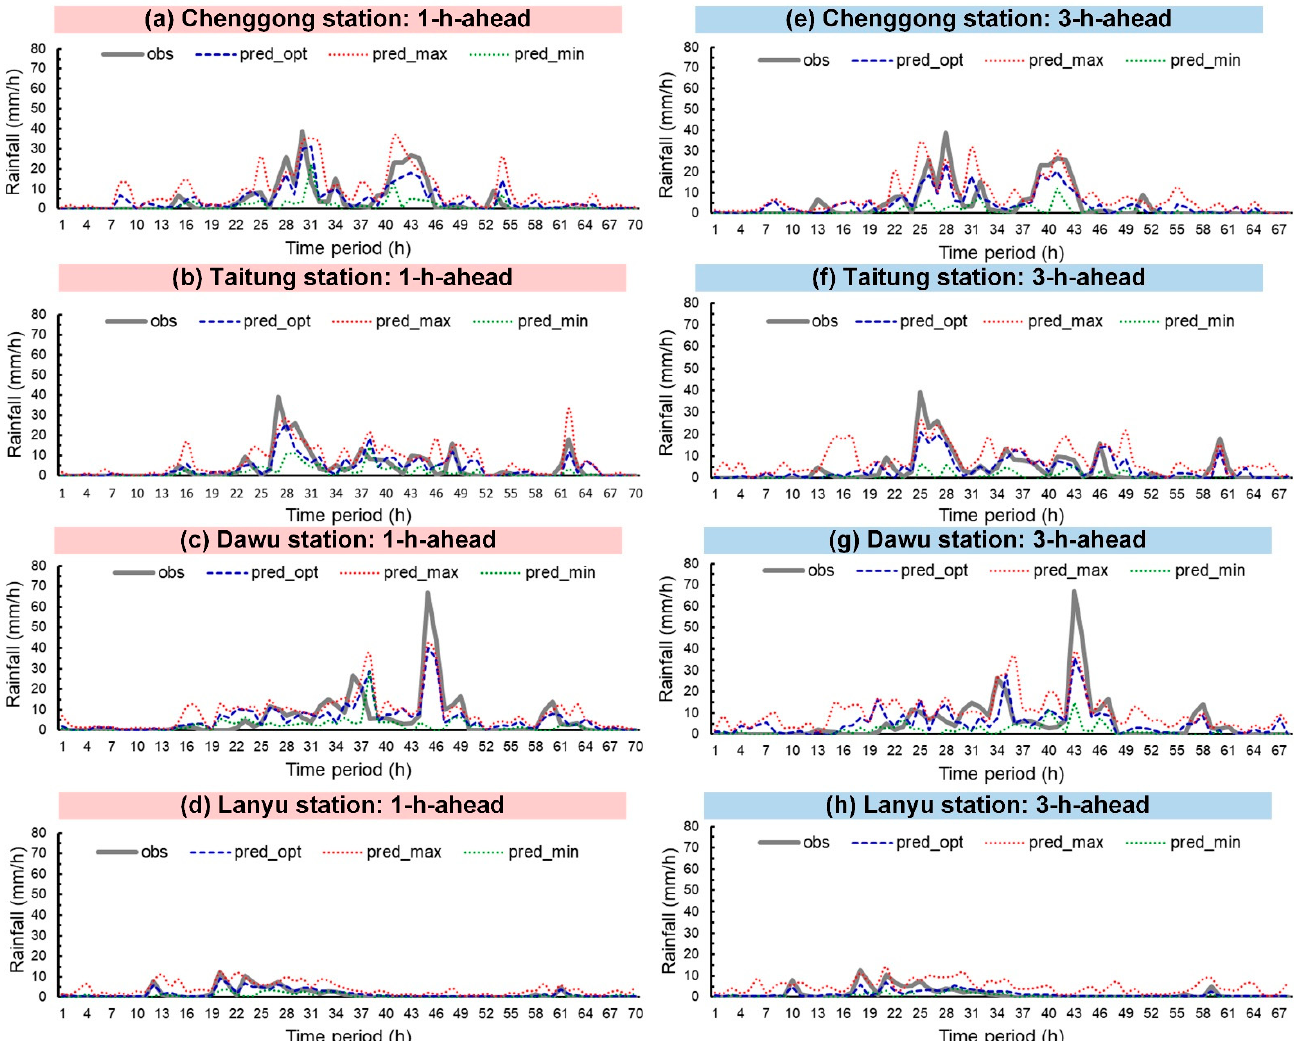
Figure 9. Typhoon Meranti prediction results: ( a – d ) lead time = 1 h; ( e – h ) lead time = 3 h.